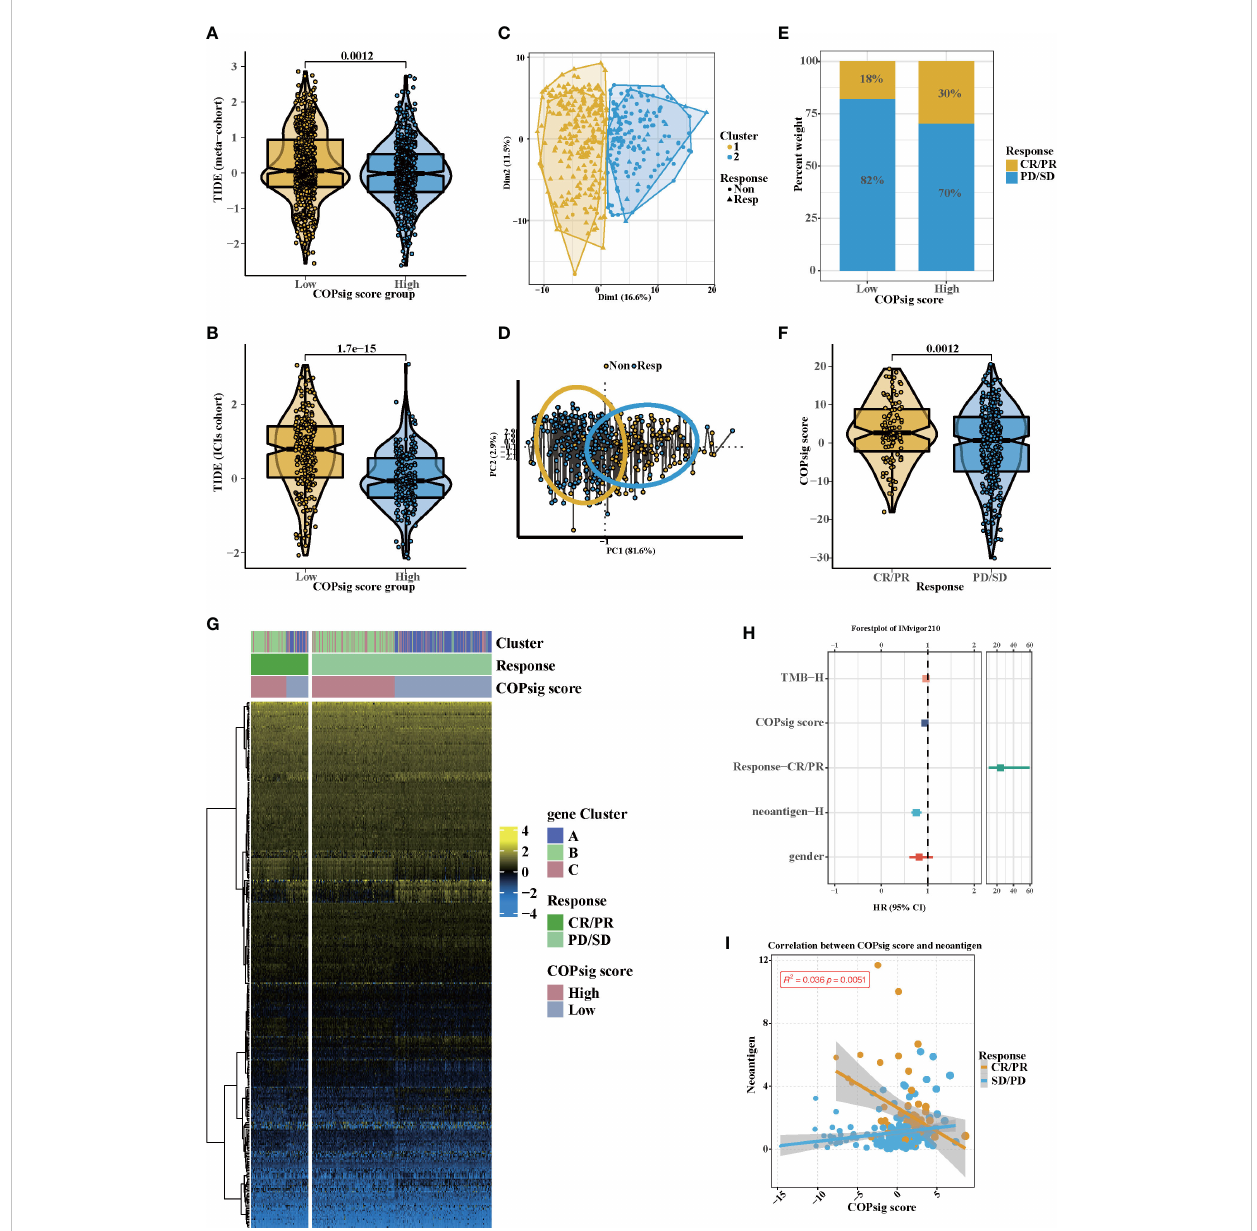
FIGURE 6 Potential immunotherapy in high and low COPsig score group. (A, B) The relative distribution of TIDE was compared between COPsig score high vs. low groups in meta-cohort (A) and ICIs cohort (B) , respectively. (C, D) Principal component analysis of the ICIs cohort and the response to ICIs. (E, F) The fraction of patients with immunotherapy response (ICIs cohort) in low and high COPsig score groups (E) . The COPsig score of CR/PR and PD/SD patients in ICIs cohort (F) . (G) Expression heatmap in meta-cohort. Gene clusters, response, COPsig score, were annotated. Yellow represented a high expression, and blue represented a low expression. (H) Univariate cox regression model estimating clinical prognosis signi fi cance between TMB, COPsig score, response, neoantigen and gender. (I) correlation between COPsig score and neoantigen in CR/PR. Yellow represented CR/PR patients, blue represented SD/PD